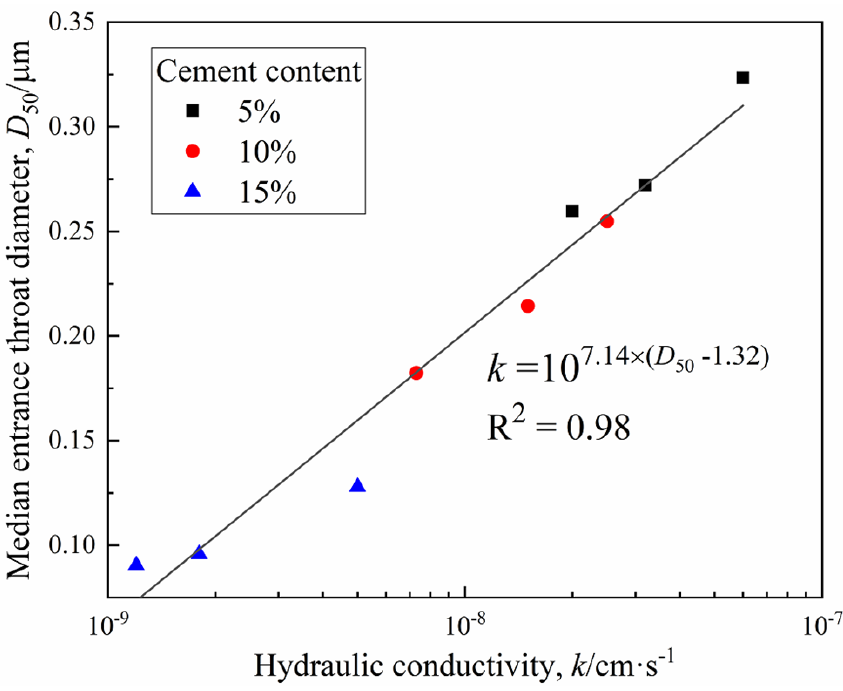
Figure 15. Relationship between k and D 50